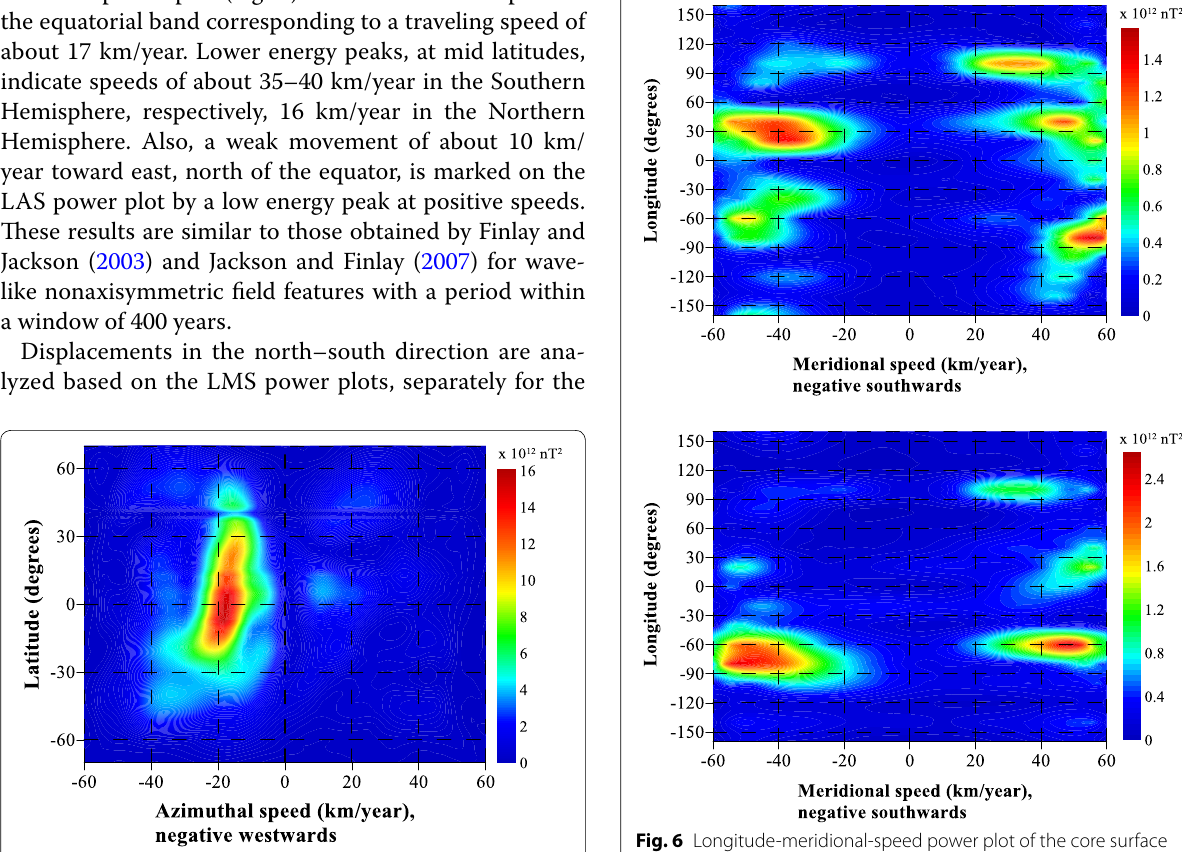
Fig. 5 Latitude-azimuthal-speed power plot of the core surface radial component of the sub-centennial constituent